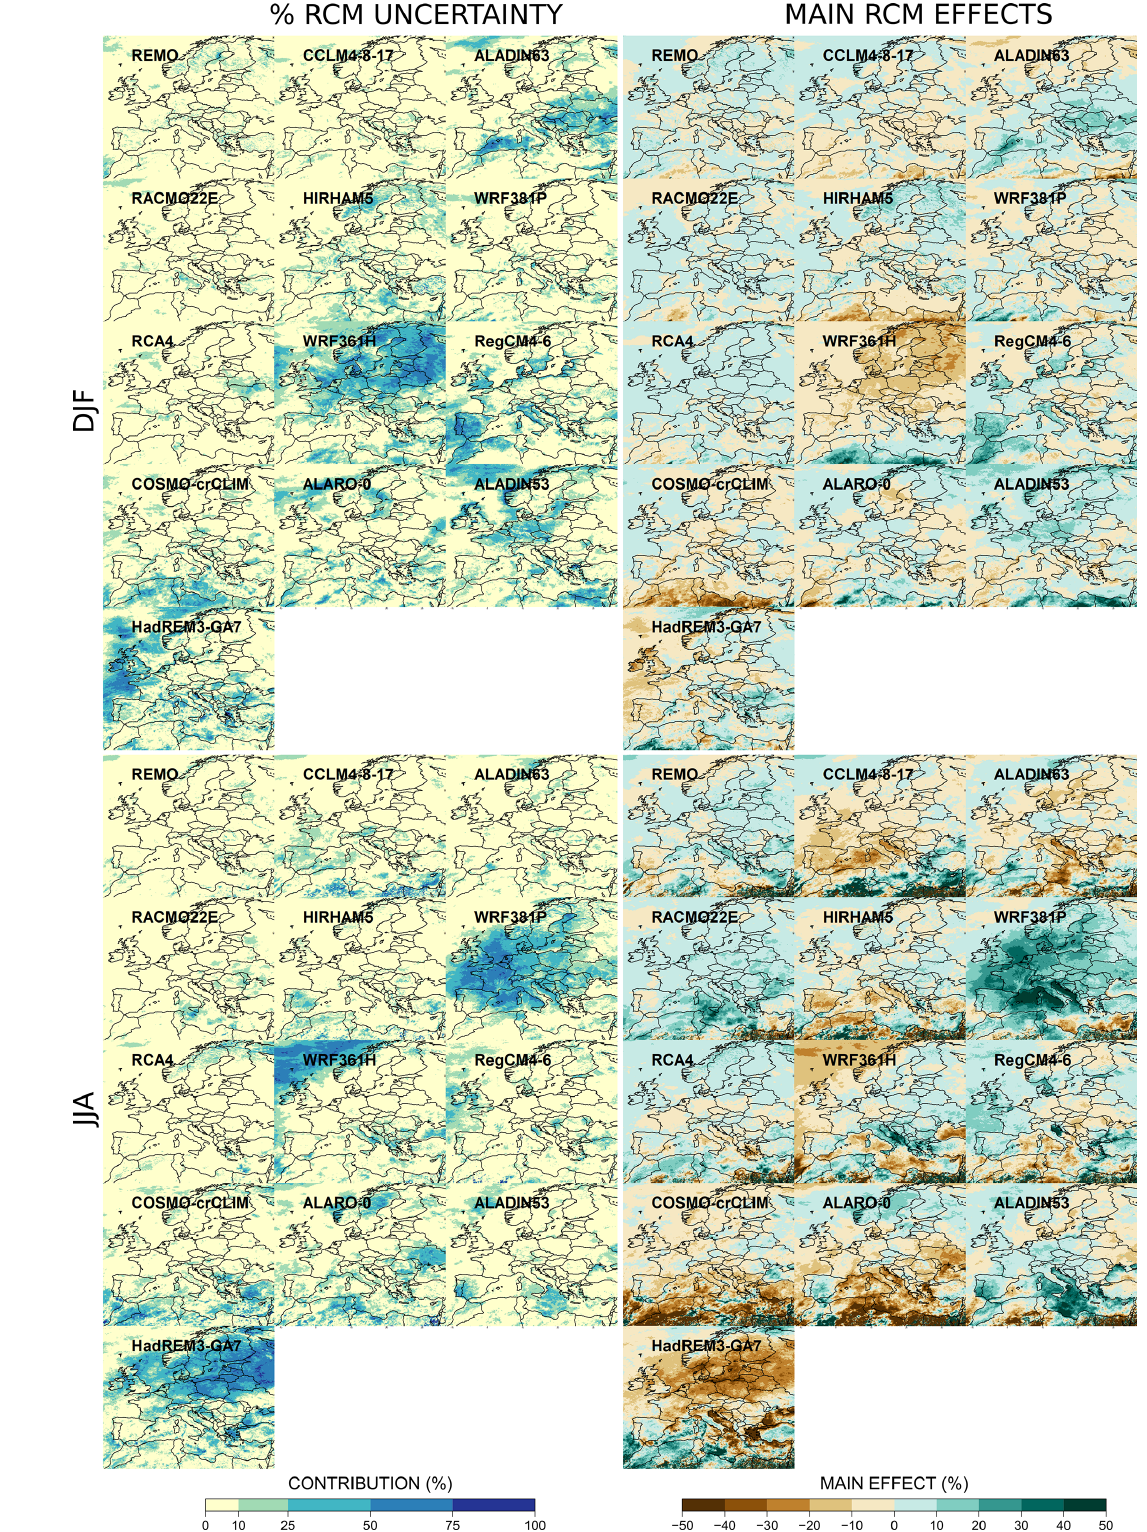
Figure 12. Fraction of RCM uncertainty (left plots) and main RCM effects (right plots) for each RCM for relative precipitation changes in winter (DJF) and summer (JJA) at the end of the 21st century (2071–2099) compared to the period 1981–2010.